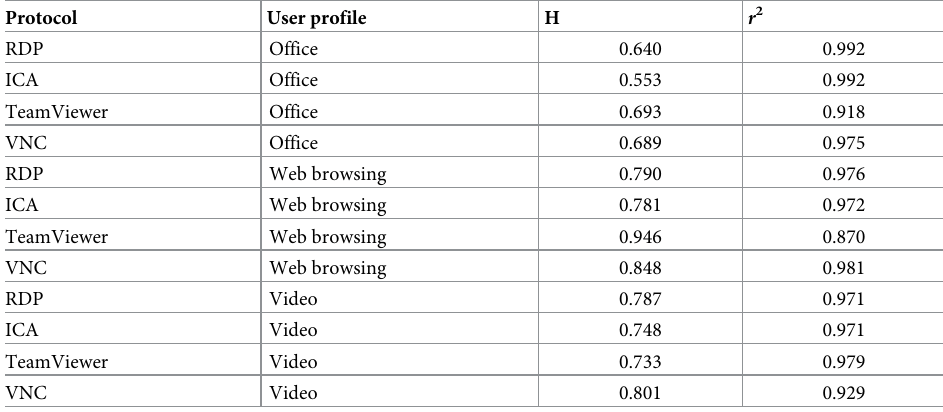
Table 5. Estimation of Hurst parameter for different remote desktop protocols and user profiles.